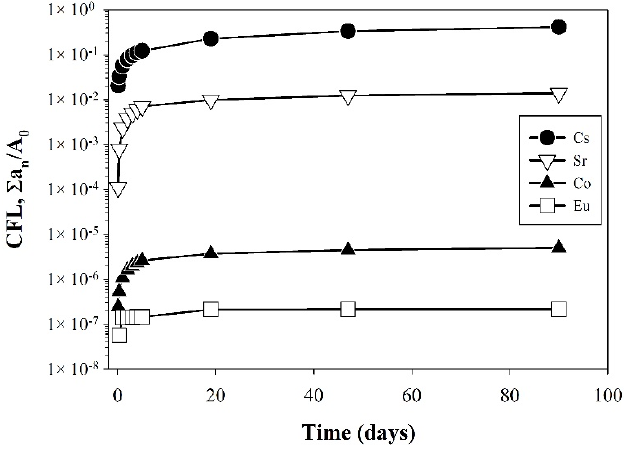
Figure 6. Cumulative fraction leached (CFL) of nuclides (Cs, Sr, Co, and Eu).